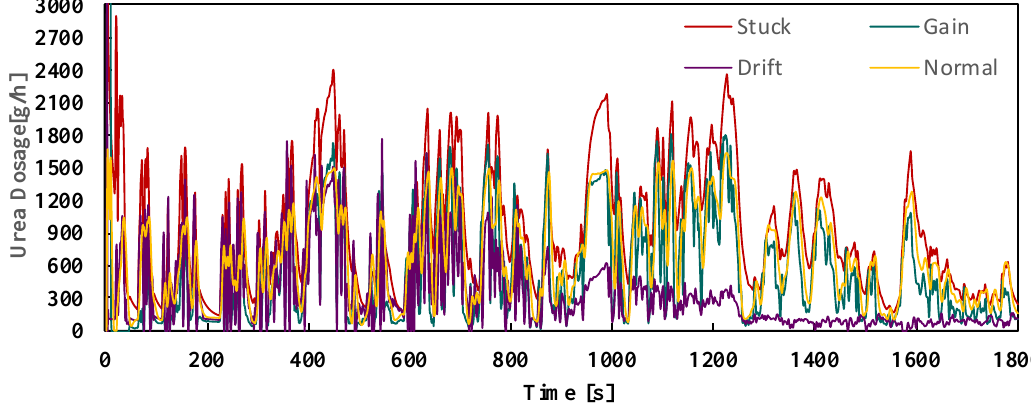
Figure 12. Urea dosage vs. time.